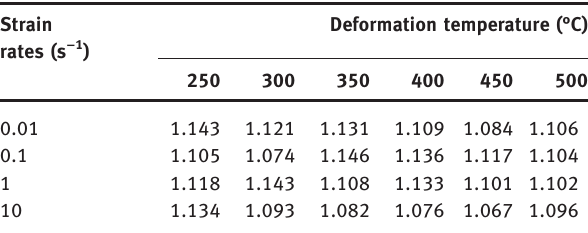
Table 1: The values of B under various deformation conditions. Strain rates (s − 